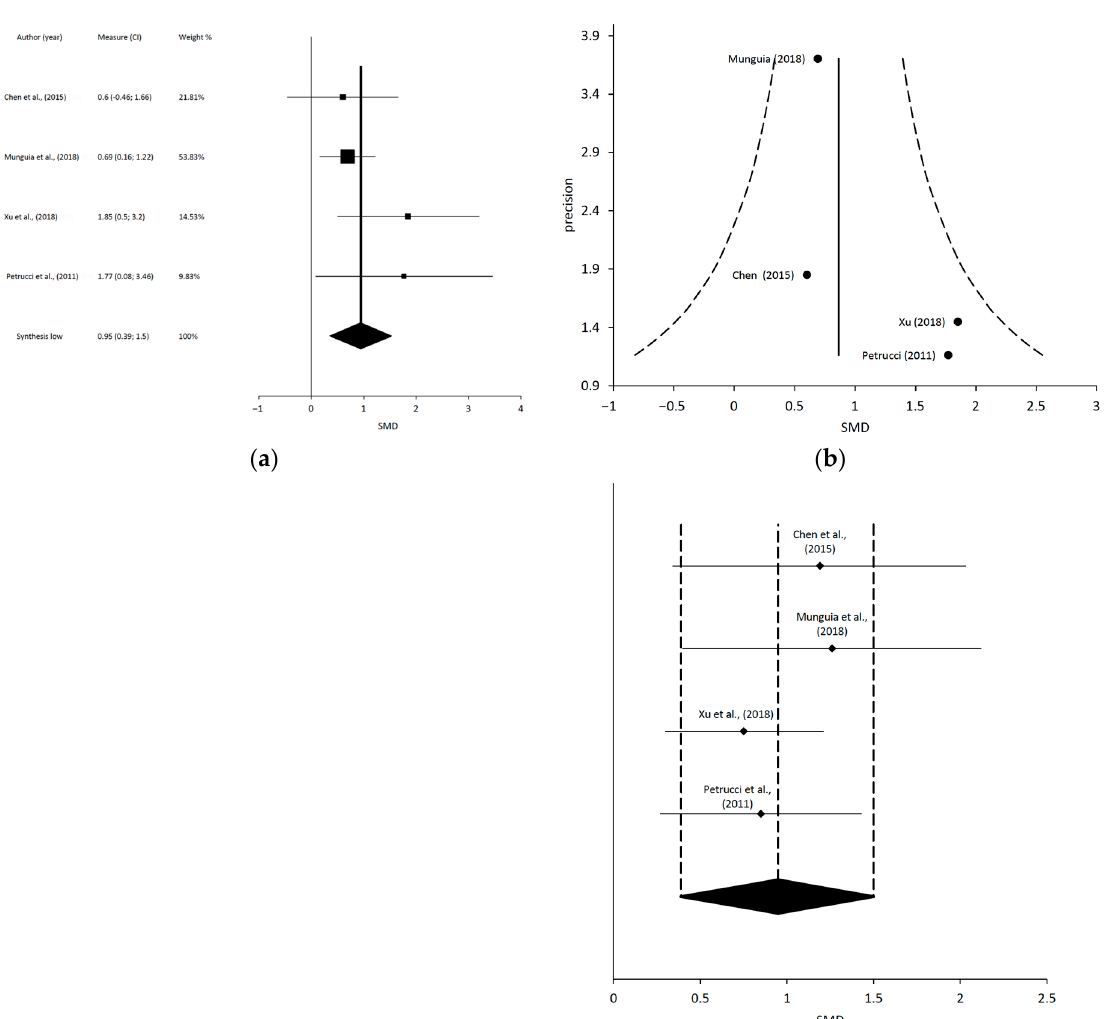
Figure 7. Synthesis forest and funnel plot of low-level laser therapy on maximum mouth opening variable [18,62,64,67]. ( a ) The forest plot summarizes the results of included studies (standardized mean differences (SMD) and weight). The small squares represent the point estimate of the effect size and sample size. The lines on either side of the box represent a 95% confidence interval. ( b ) Funnel plot aims to assess the existence of publication bias. ( c ) Sensitivity plot.